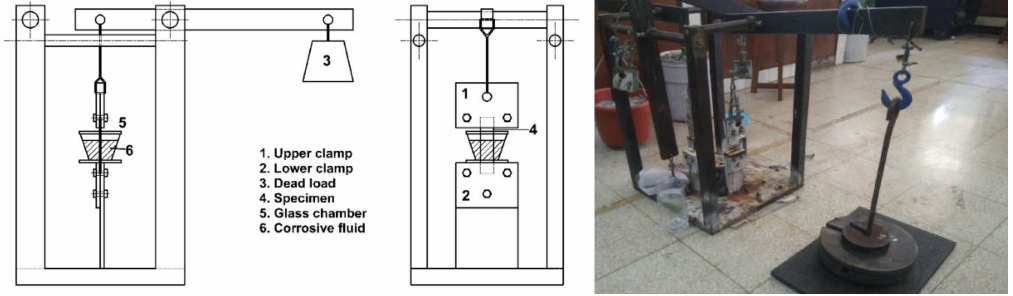
Figure 2. The stress corrosion cracking (SCC)